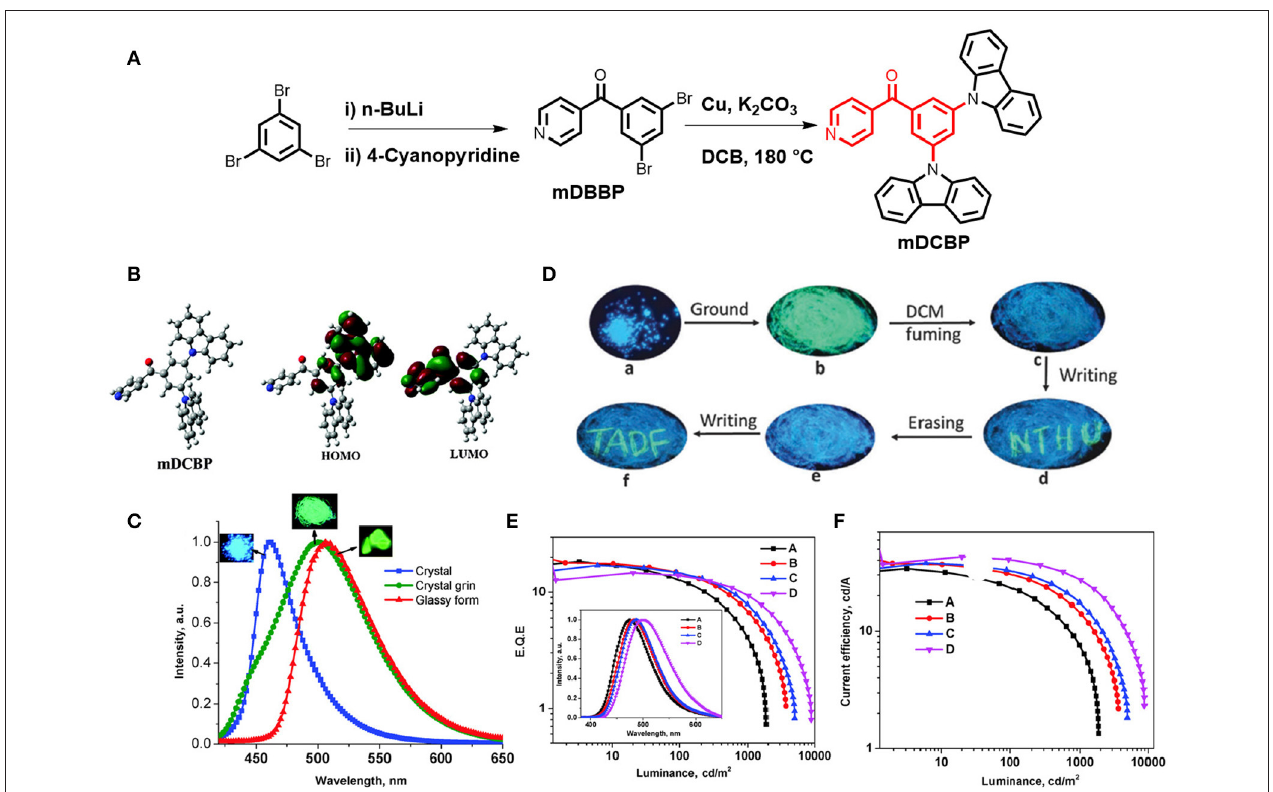
FIGURE 2 | (A) Chemical structure of mDCBP and its synthetic scheme. (B) Optimized molecular configuration of mDCBP and calculated HOMO-LUMO with spatial distribution. (C) Emission spectra of mDCBP in its various forms (crystalline, amorphous and glassy); insets are the respective images under UV-irradiation. (D) MCL behavior of mDCBP in response to various external mechanical stimuli. (E) External quantum yields of the fabricated devices (A–D) ; insets are the EL spectra of the devices. (F) Current efficiency vs. luminescence plot. Reproduced with permission from Rajamalli et al. (2016). Copyright © The Royal Society of